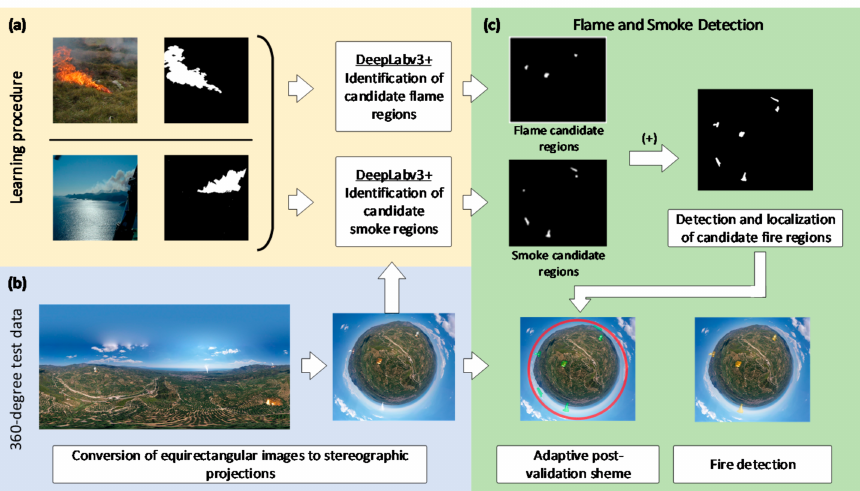
Figure 1. The proposed methodology: ( a ) Learning procedure of two DeepLab v3 + networks, ( b ) conversion of equirectangular raw images to stereographic projection format images, ( c ) post-validation of the fire detected images.